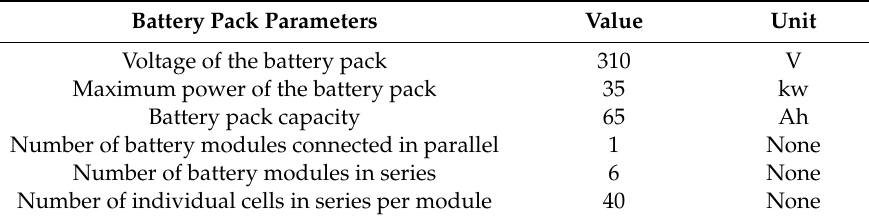
Figure 2. Schematic diagram of the battery pack. Table 1. Battery pack parameters.